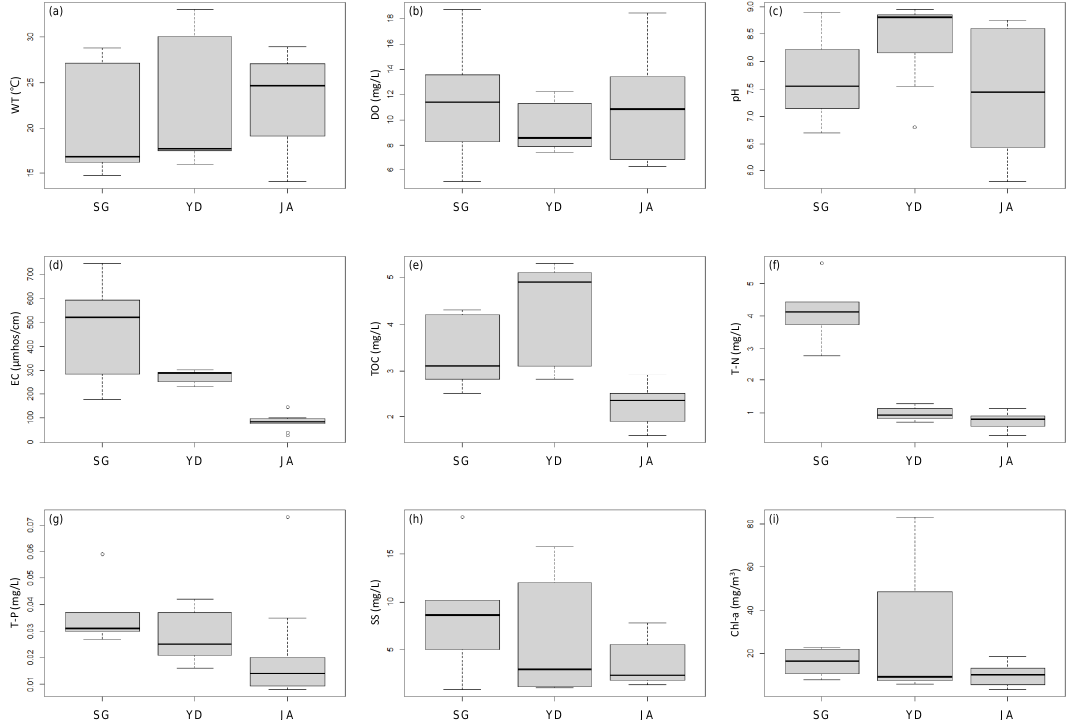
Figure 2. Mean values of water temperature ( a ), dissolved oxygen ( b ), potential of hydrogen ( c ), electrical conductivity ( d ), total organic carbon ( e ), total nitrogen ( f ), total phosphorus ( g ), suspended solids ( h ), and chlorophyll a ( i ) measured from the SG, YD, and JA in Korea.